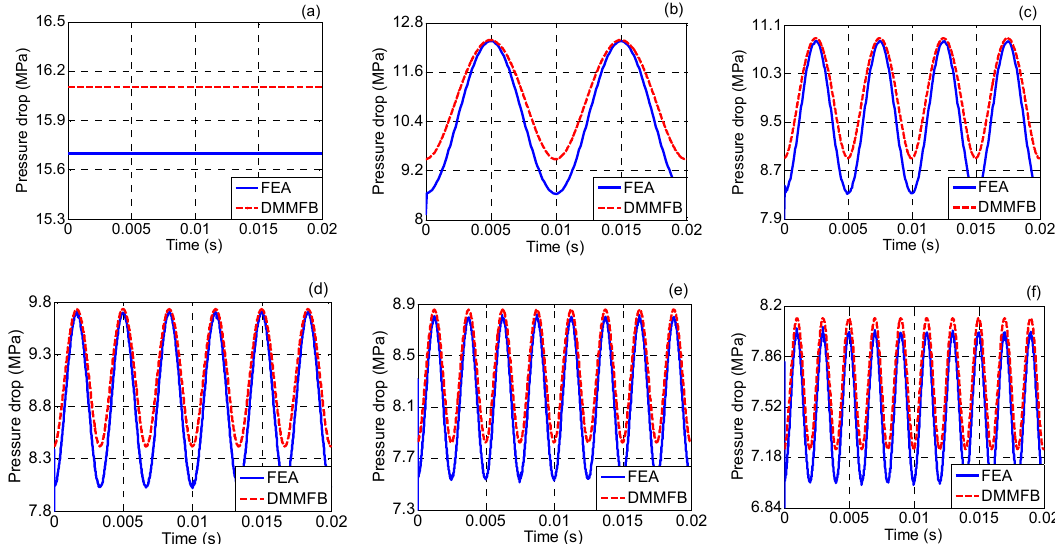
Figure 5. The internal pressure drop of the extrusion liquefier without and with 0.3 g vibration applied at different frequencies. ( a ) No vibration applied, ( b ) 100 Hz, ( c ) 200 Hz, ( d ) 300 Hz, ( e ) 400 Hz, ( f ) 500 Hz.